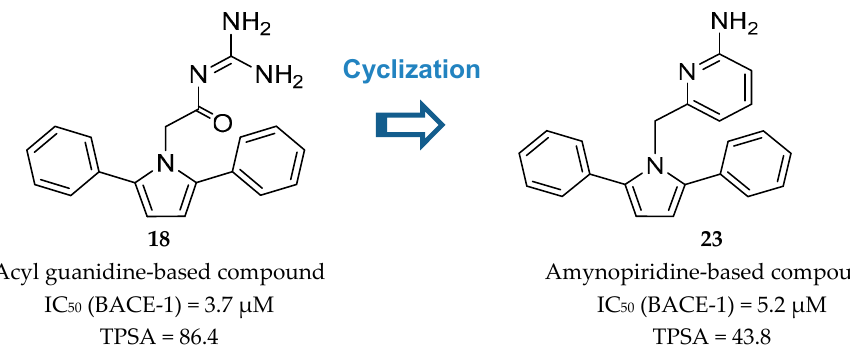
Figure 20. Bioisosteric replacement of the acyl guanidine moiety of compound 18 .